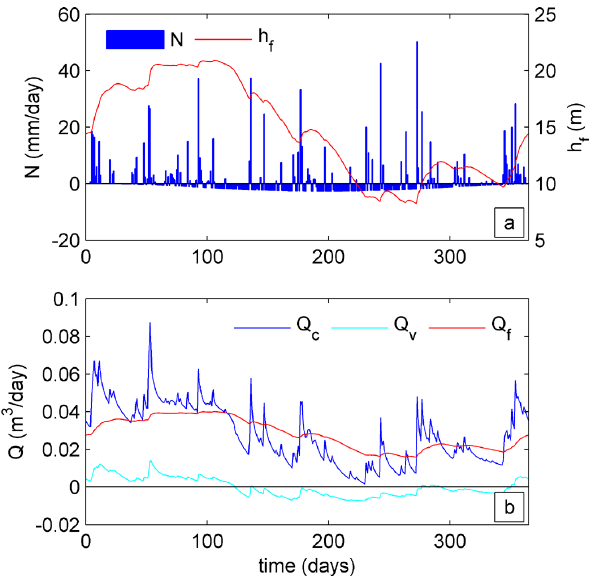
Fig. 3. Dynamic equilibrium of the large system for 1958. (a) Recharge ( N) and simulated water level in fissure ( h f , shown with respect to bottom of fissure). (b) Outflow from colluvium ( Q c ) , inflow from fissure into varved clays ( Q v ) , and outflow from fissure ( Q f )